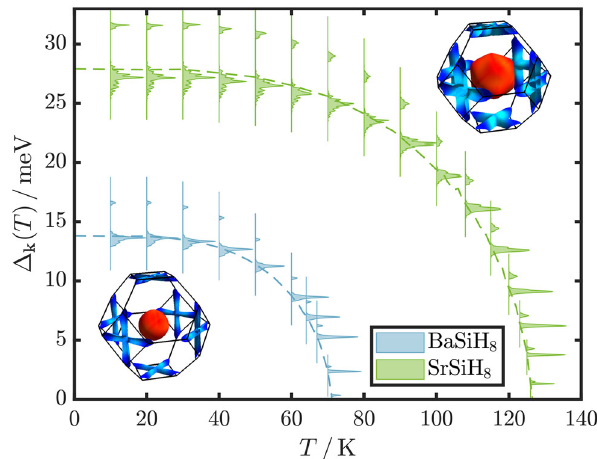
Fig. 4 Superconducting gap as a function of temperature. Δ ( T ) for BaSiH 8 (blue) at 5 GPa and for SrSiH 8 (green) at 30 GPa calculated using the fully anisotropic ME theory; dashed lines indicate the mean value as a guide to the eye. The insets in the top right and bottom left corner show the Fermi surface distribution of Δ k at 10 K for BaSiH 8 and SrSiH 8 respectively; blue/red correspond to min( Δ )/ max( Δ ).